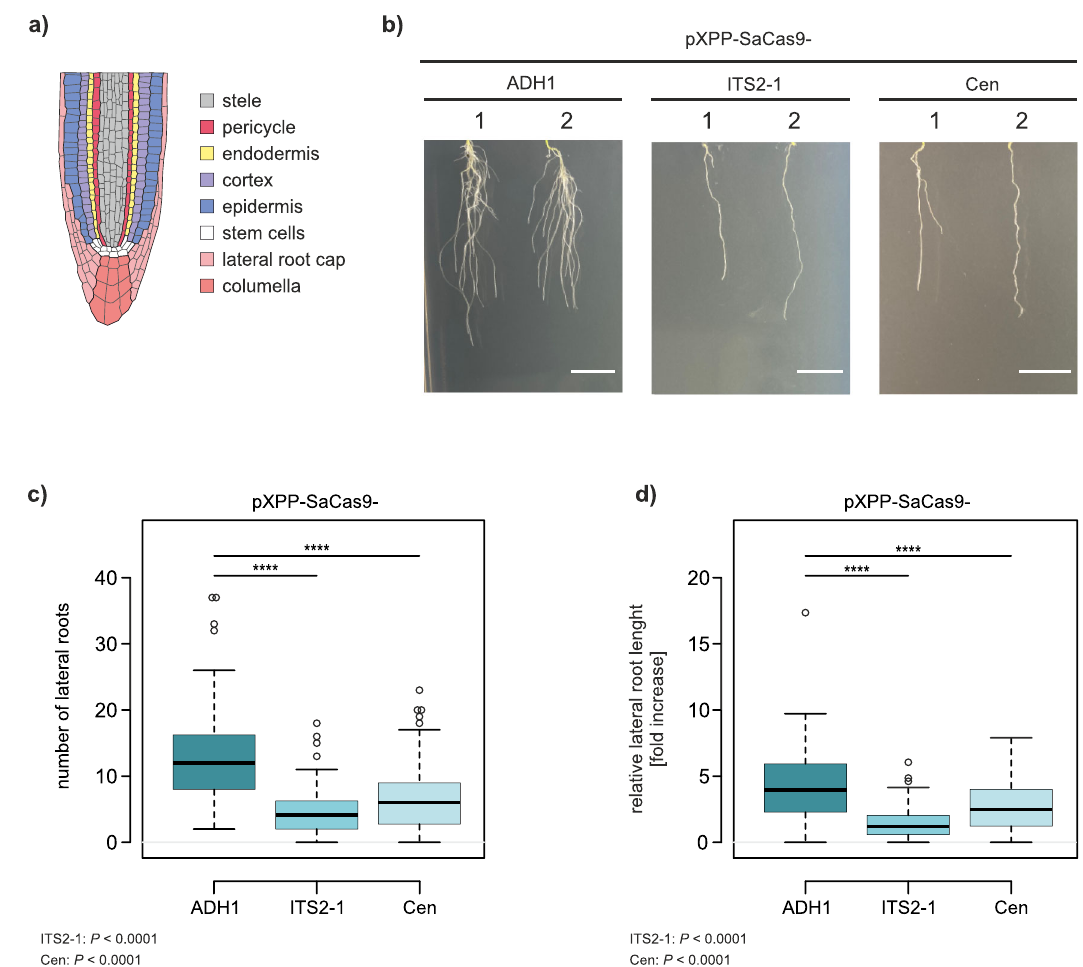
in the A. thaliana root tip. The root tip consists of the lateral root cap and columella (pink). The central cells of the root (stele, gray) are framed by pericycle cells (red), followed by endodermis (yellow), cortex (purple), and epidermis (blue), which arise from the stem cell niche (white). Lateral roots arise from the pericycle cells (red). b Representative pictures of lateral roots in both CRISPR-Kill lines (pXPP-SaCas9-ITS2-1 and pXPP-SaCas9-Cen) in comparison to the control line (pXPP-SaCas9-ADH1). Bar = 1 cm. c Total number of lateral roots in control line and CRISPR-Kill lines. The control line,